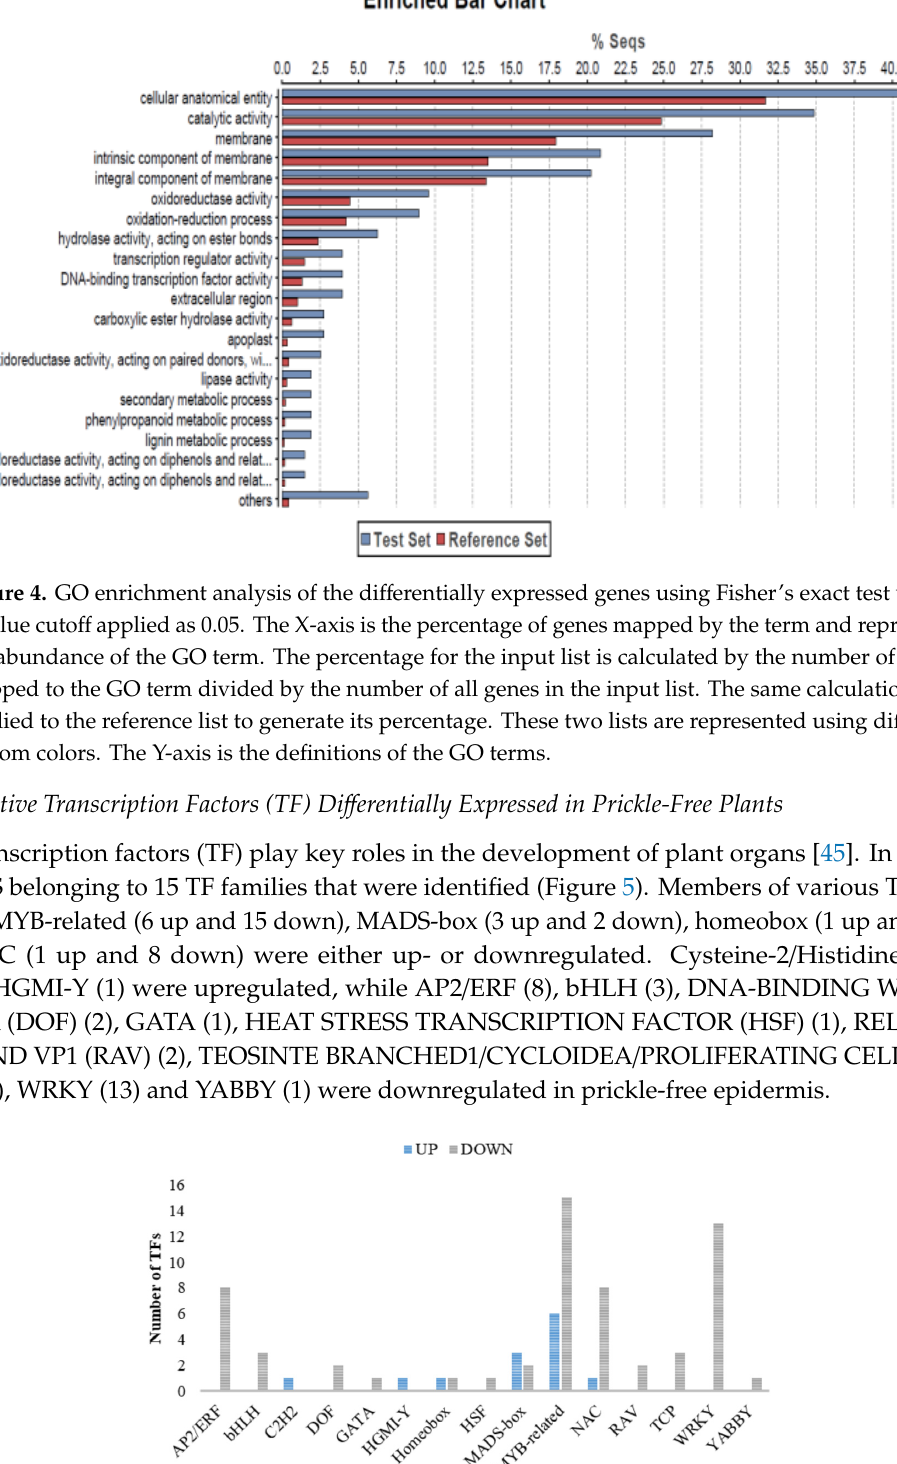
Figure 6. Relative expression patterns of plant development-related transcription factors (TFs) in prickled and prickle-free epidermis. Error bars represent SE of means of triplicates. 4. Discussion Previous studies have shown that prickle development in Rubus species is associated with presence or absence of glandular structures resembling trichomes early in development [16,18]. Glandular or secreting trichomes are present in many vascular plants and are multicellular structures with secreting glands at the tip of the stalk which often produce and store terpenoids, phenylpropanoid oils and other secondary metabolites [46,47]. The transcriptional network regulating the development and patterning of unicellular trichomes is well characterized in Arabidopsis , however, understanding the development of glandular trichomes is cursory at this stage